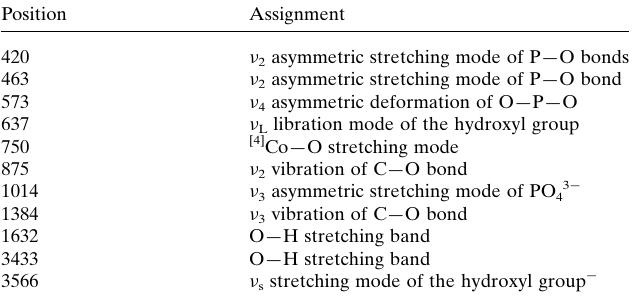
Table 2 Assignments of infrared vibration bands (cm (cid:5) 1 ) for SrCo 4 (OH)(PO 4 ) 3 . Position Assignment